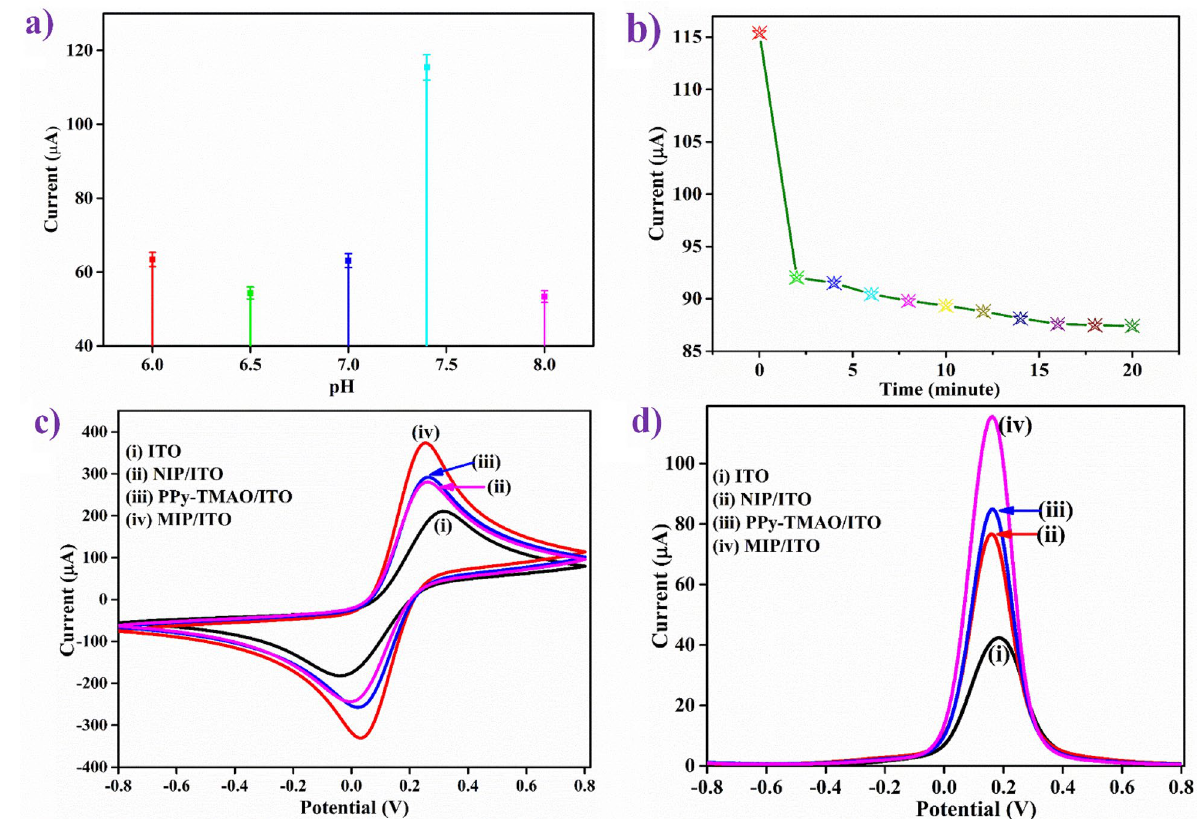
Figure 1. Electrochemical studies of MIP/ITO electrode ( a ) effect of pH; and ( b ) response time. Comparative ( c ) CV and ( d ) DPV study of ITO (curve i); NIP/ITO (curve ii); PPy-TMAO/ITO (curve iii); and TMAO/ITO (curve iv) in PBS (0.2 M, 0.9% NaCl) containing 5 mM of [Fe(CN) 6 ] 3−/4− MIP/ITO electrode took approximately 20 min. Thus, an optimum time of 20 min was given to the interaction of TMAO and MIP/ITO electrode before taking every reading for the electrochemical response studies. Electrode study. The fabricated MIP/ITO electrode was used to detect TMAO. The electro-activity of the elec- trodes MIP/ITO, NIP/ITO, and PPy-TMAO/ITO was studied through CV and DPV studies. Figure 1(c) shows CV response of (i) ITO (ii) NIP/ITO (iii) PPy-TMAO/ITO and (iv) MIP/ITO electrodes at a scan rate of 50 mV/s in the potential range of -0.8 to 0.8 V in PBS containing [Fe(CN) 6 ] 3−/4− as a redox species. It was observed that in comparison to ITO (210.44 μA), the NIP/ITO, MIP/ITO and PPy-TMAO/ITO electrodes manifested more current values, (i.e., these were more conductive) and this can be assigned to PPy being a conducting polymer, which is highly electroactive that aids in the conduction of ions. As shown in Fig. 1(c), the peak current in the CV curve NIP/ITO and incorporation of TMAO into the PPy matrix (i.e., PPy-TMAO) showed almost the same values with a slight shift in the peak voltages. NIP/ITO electrode showed the lowest peak current (280.42 μA; curve ii). The incorporation of TMAO into PPy, i.e., PPy-TMAO/ITO electrode, increased this current slightly (291.99 μA; curve iii). Further, the increase in peak current was observed after the removal of TMAO from PPy-TMAO by ultra- sonication to form MIP/ITO electrode (373.56 μA; curve iv), since TMAO acts as an oxidant. Moreover, when the template was removed, there were more free-NH groups available in PPy that leads to an increase in the electro-activity and thereby resulting in an escalation in the CV peak current of MIP. The change in the peak currents in the electrode study, and the changes in the FTIR spectra indicated that TMAO was successfully removed from the MIP. The DPV scans were also coherent with the trend of current values observed in CV scans as shown in Fig. 1(d). Scan rate study. Figure 2(a,b) shows the CV scans that were run to examine the electro-kinetics of NIP/ITO and MIP/ITO electrode occurring at the interface between the surface of the electrode and electrolytes in the solution using a scan rate of 10 to 100 mV/s. The I pa /I pc ratio for the MIP/ITO electrode was determined to be 0.92. The ratio is close to 1, which suggests the quasi-reversible electron transfer kinetics 52,53 . The I pa /I pc ratio for the NIP/ITO electrode was determined to be 0.82, which pointed towards the progression of an irreversible electron transfer between the electrode and the medium [as shown in the upper inset of Fig. 2(a,b)]. The slopes and intercepts for these I pa and I pc curves can be determined from equations (S1) to (S4).